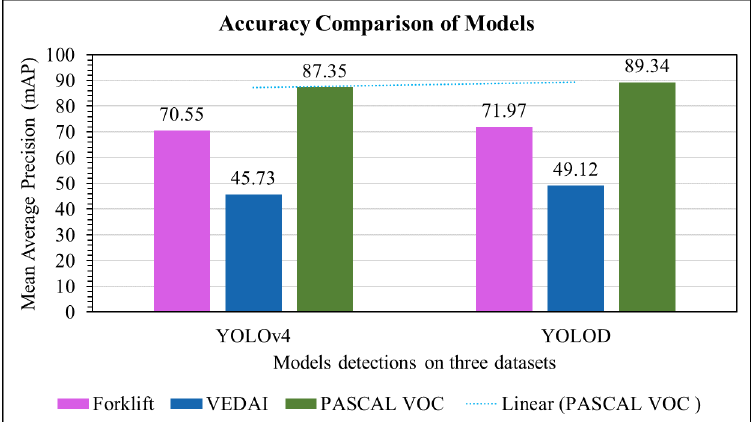
Figure 11. mAP of the target model based on three